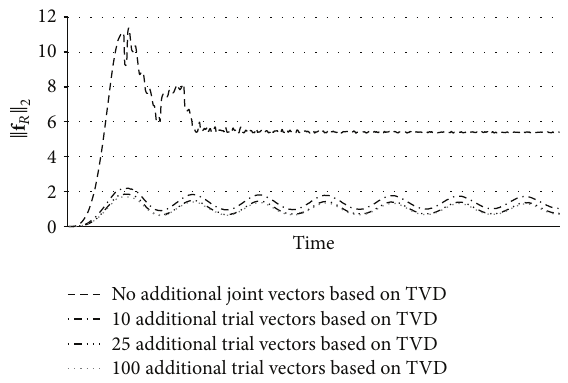
Figure 12: Time evolution of the Euclidean norm of the friction forces.